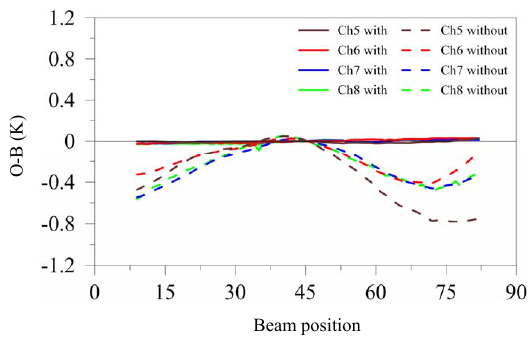
Figure 10. Averaged scan bias with (solid lines) and without (dashed lines) bias correction for MWTS-2 during 1–27 July 2014.